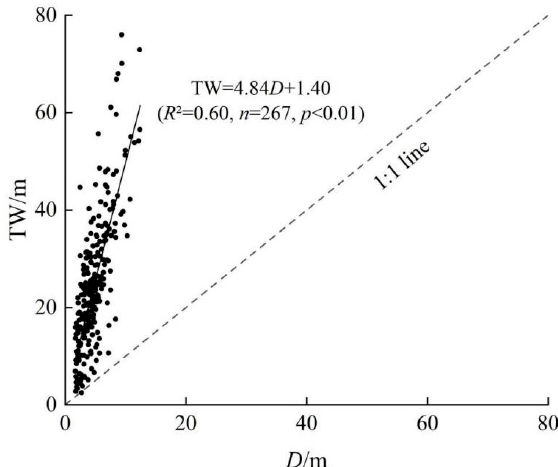
Figure 8. The TW ‐ D relation of the gullies.